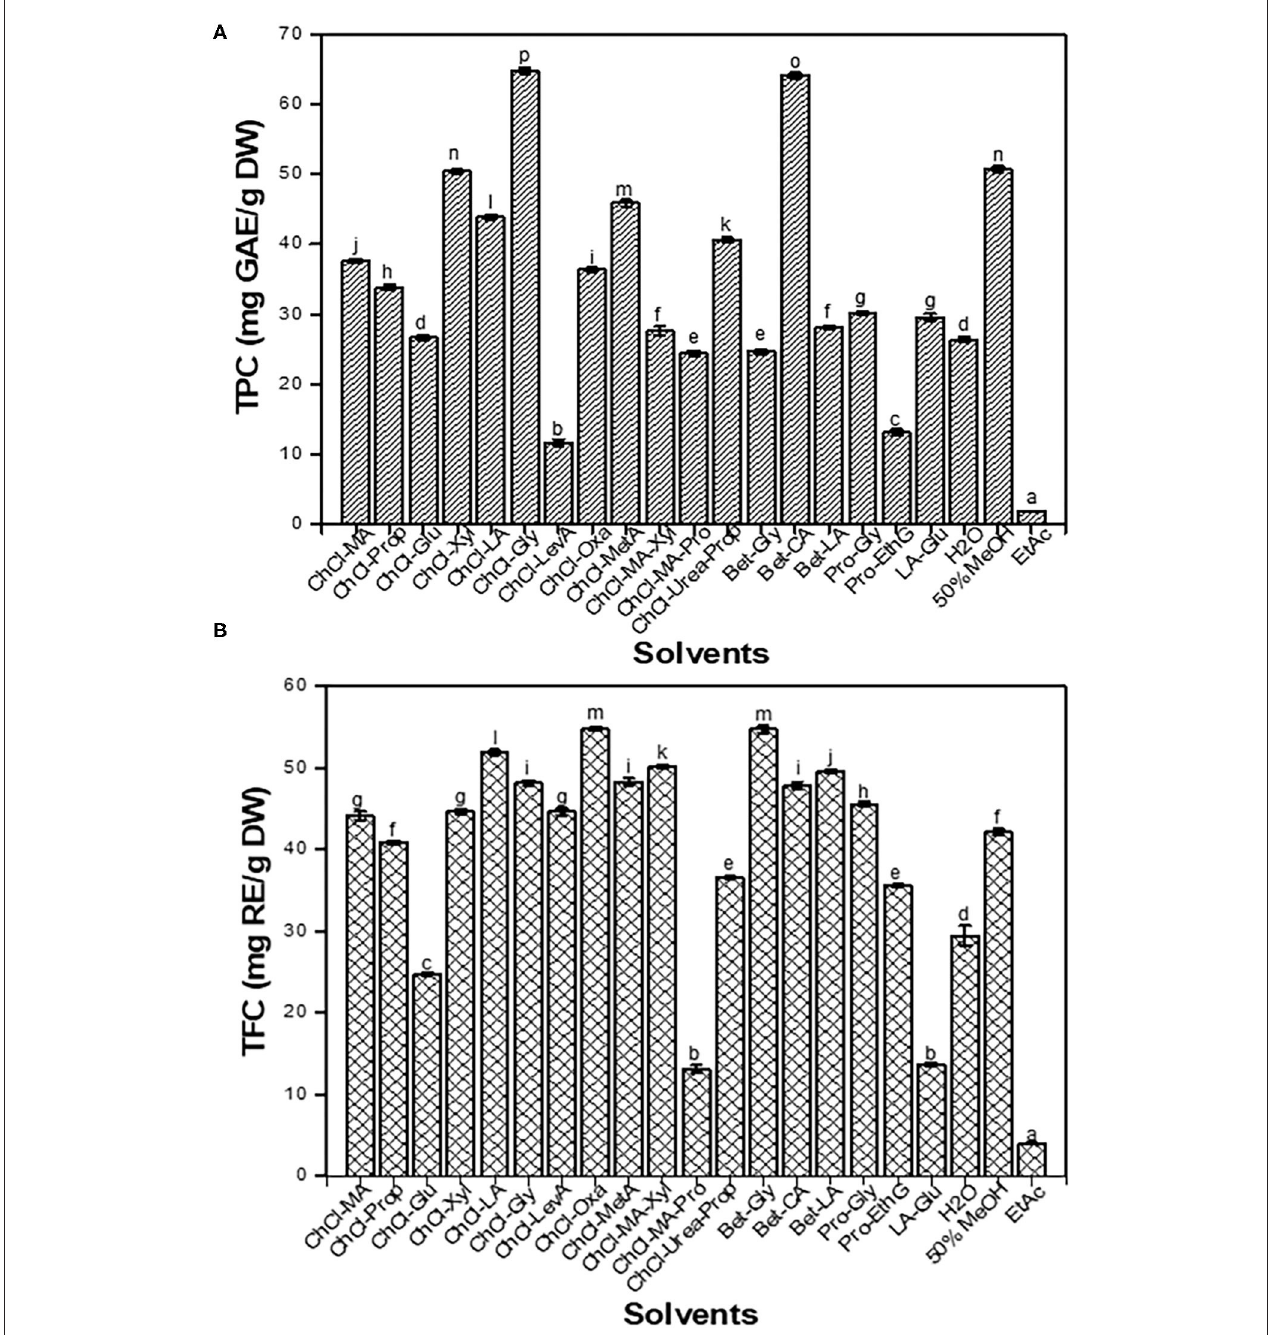
FIGURE 1 | Total phenolic content (TPC) (A) and total flavonoid content (TFC) (B) of the Clausena indica (Datz.) Oliv fruit pericarps (CIOPs) extracts were obtained by the traditional solvents and deep eutectic solvents (DESs). Different lowercase letters (a–m) mean statistically significant differences in TPC/TFC extracted with different